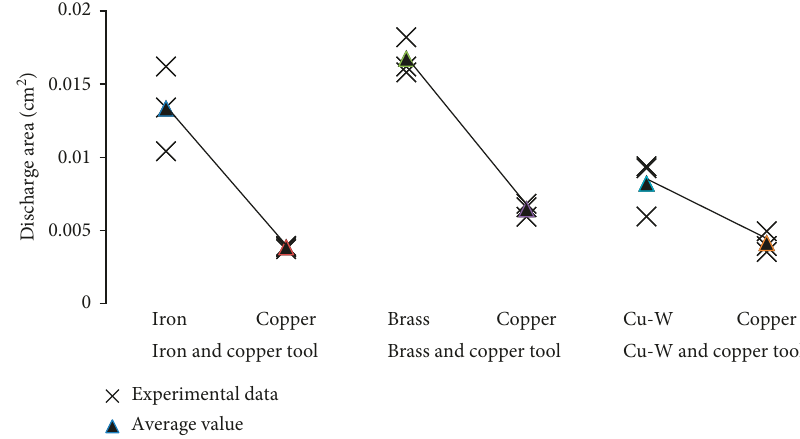
Figure 6: Discharge area on the surface of different multimaterial